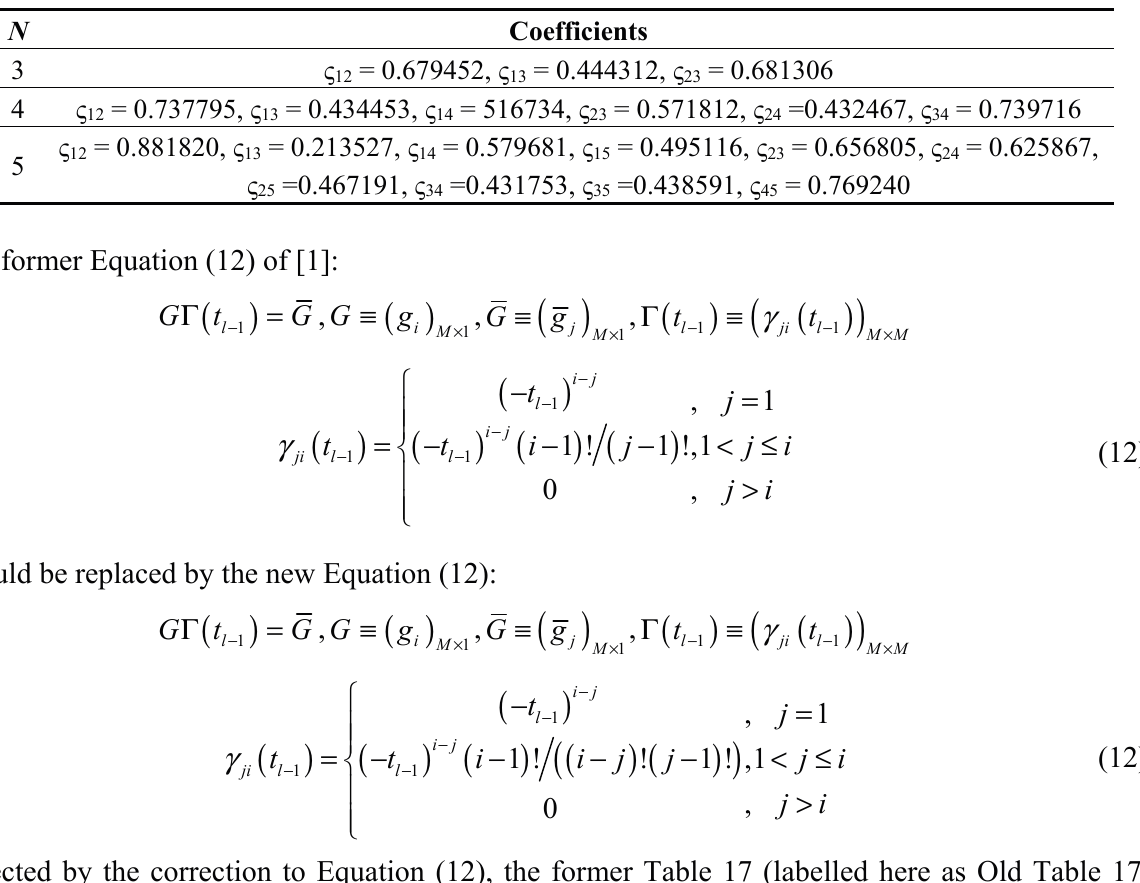
New Table 10. LMSuc algorithm